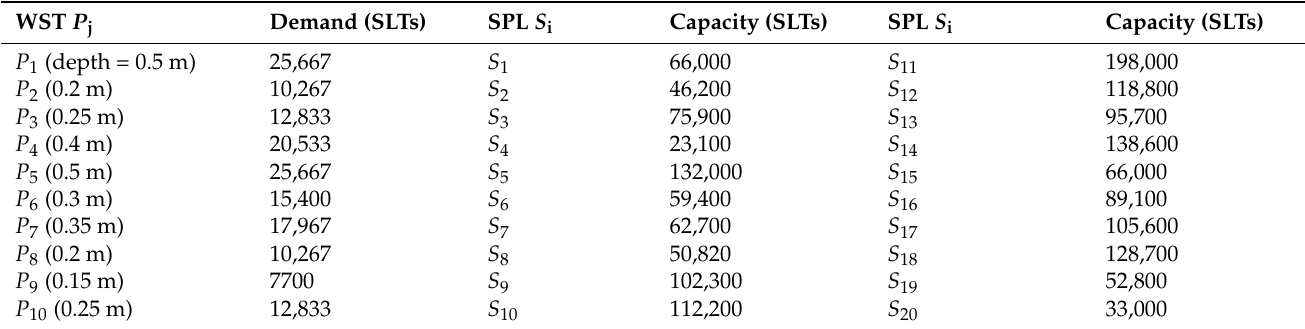
Table 3. WST demands and SPL capacities (measured in